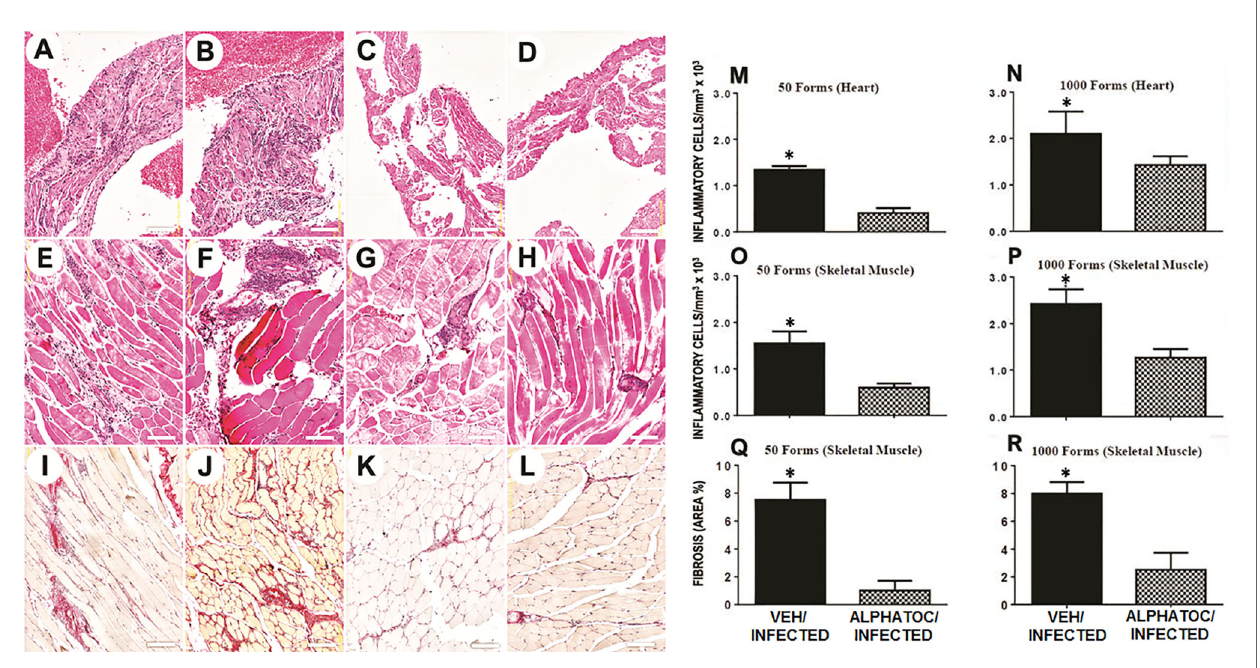
FIGURE 5 | Morphometric analysis and fi brosis of in fl ammatory in fi ltrate after 60 days of infection with 50 or 10 3 forms of T. cruzi . Representative images of the histological lesions are depicted in fi gures (A – L) . Morphometric analyses of the in fl ammatory in fi ltrate and fi brosis area are shown in fi gures (M – R) . Heart atrium is shown in fi gures (A – D) . Skeletal muscle is depicted in fi gures (E – H) . Figures (I – L) show representative images of the skeletal muscle fi brosis. All the histological analysis was performed in C57BL/6 mice after 60 days of infection with 50 (A , C , E , G , I , K) or 10 3 (B , D , F , H , J , L) trypomastigotes. Mice were pretreated with vehicle alone (A , B , E , F , I , J) or alphatoc (C , D , G , H , K , L) . The groups with signi fi cant differences are represented with ( * ), Mann Whitney test, n= 4, P<0.05.